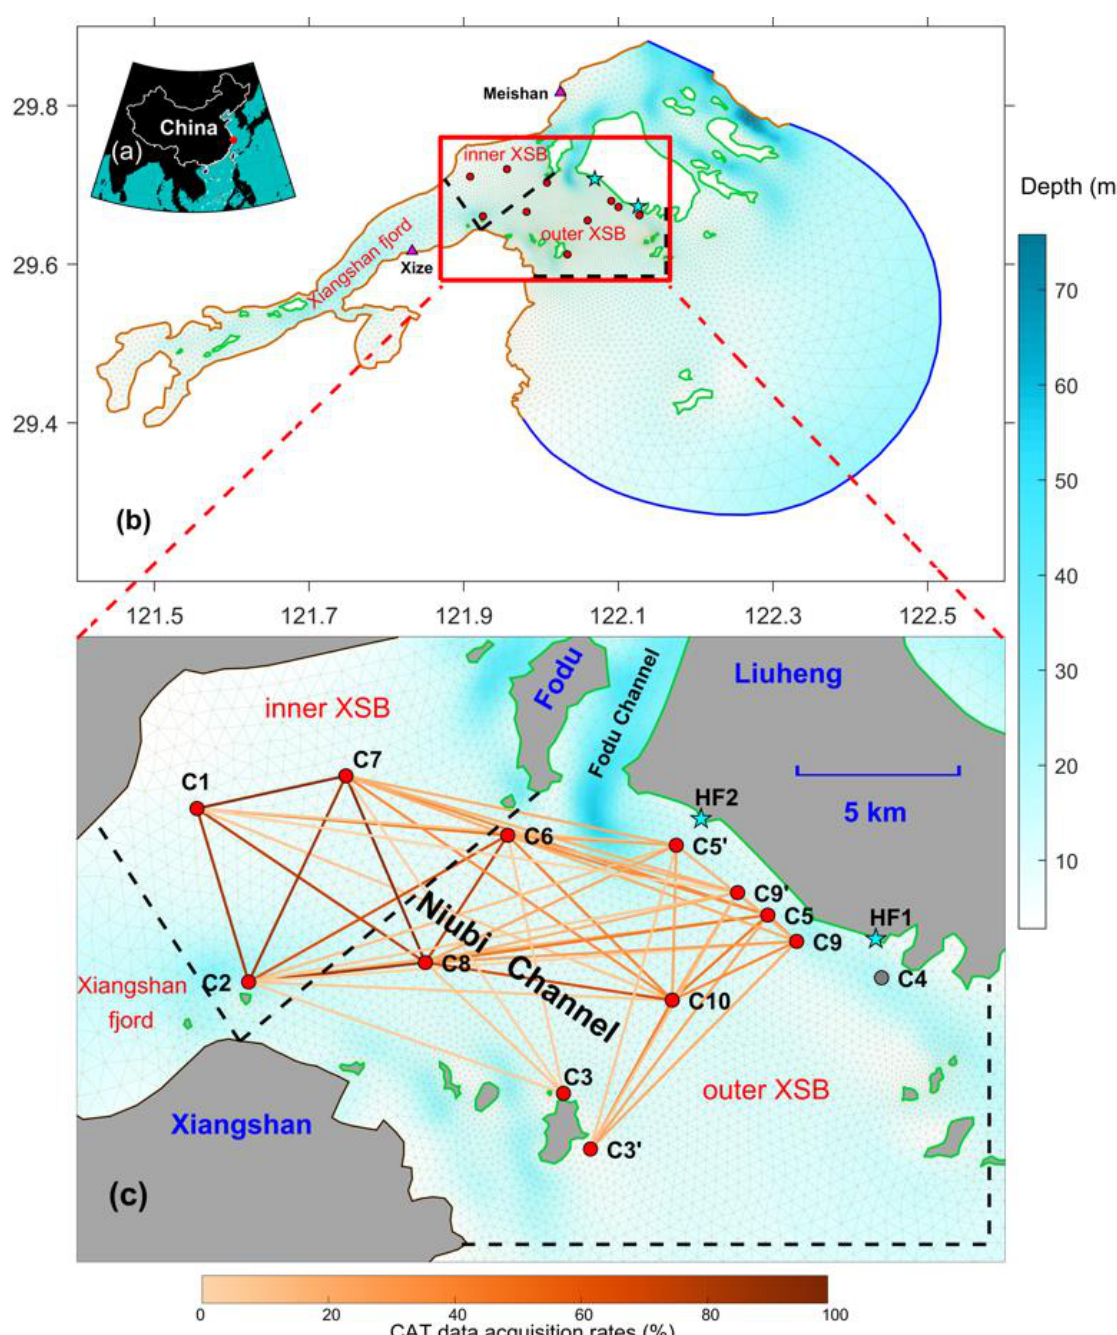
Figure 1. ( a ) Location of our study site (red dot), Xiangshan Bay (XSB), China. ( b ) Ocean model grid (grey triangles) of XSB. The thick brown, green, and blue lines indicate the mainland, island, and open boundaries, respectively. The magenta triangles, red dots, and cyan stars indicate the tidal level, coastal acoustic tomography (CAT), and high-frequency ground wave radar stations, respectively. The Xiangshan fjord, inner XSB, and outer XSB are separated by black dashed lines. ( c ) Tidal current observation domain. The lines indicate the horizontal projection of acoustic rays between the CAT station pairs; the color intensity of the lines represents data acquisition rates between each CAT station pair. In both ( b , c ), the blue shading indicates the bathymetry (in m) of XSB.